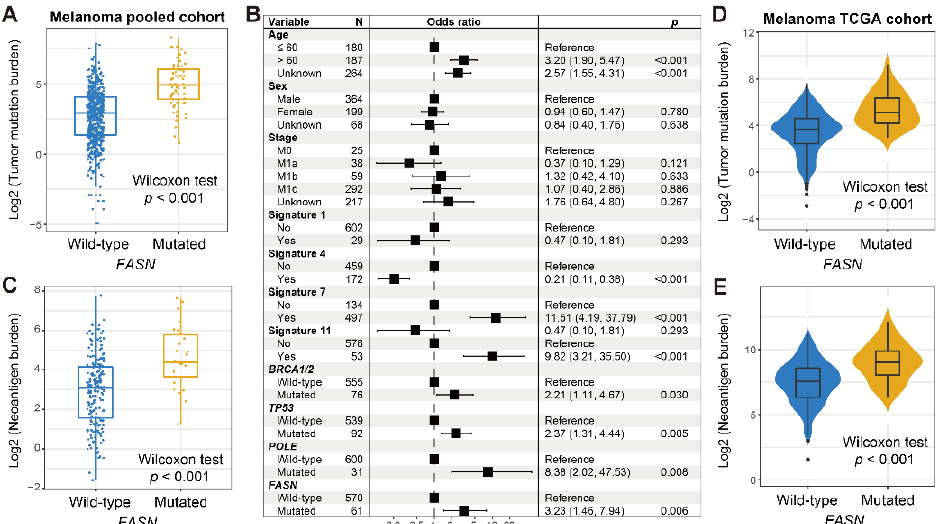
Figure 3. Association between FASN mutations and mutational burden in melanoma. ( A ) Distinct distribution of TMB in FASN two subgroups in the pooled cohort. ( B ) Multivariate logistic regression model of FASN mutations was conducted with clinical factors, extracted mutational signatures, and genomic maintenance regulator mutations taken into account. ( C ) Distinct distribution of NB in FASN two subgroups. Association of FASN mutations with ( D ) TMB and ( E ) NB in the TCGA cohort.